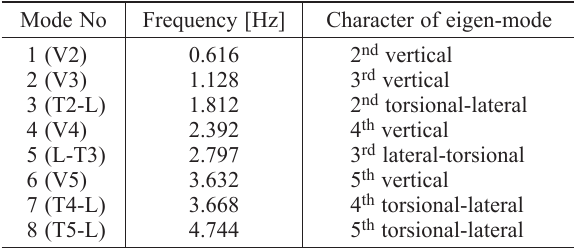
Fig. 5. A comparison of mid-span deflections obtained by FE analysis and analytical formula (1) for different values of the bending stiffness parameter ξ of the cable Table 1. Computed eigen-frequencies and eigen-modes Mode No